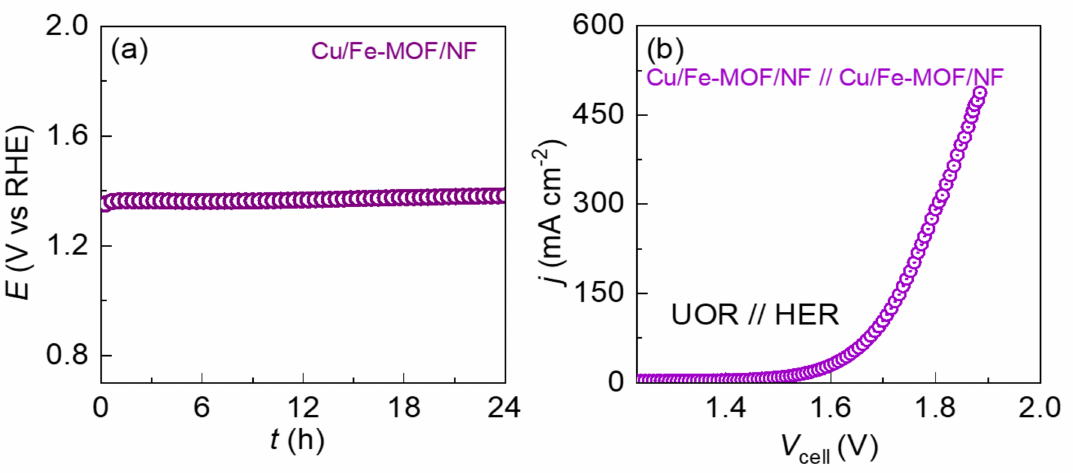
Figure 6. ( a ) Chronoamperometric stability test for the Cu/Fe-MOF/NF in the half-cell configuration system at a current density 10 mA cm − 2 in 1.0 M KOH containing 0.33 M urea. ( b ) Polarization curves of overall urea oxidation electrolyzers with the electrode pairs: Cu/Fe-MOF/NF || Cu/Fe-MOF/NF in 1.0 M KOH containing 0.33 M